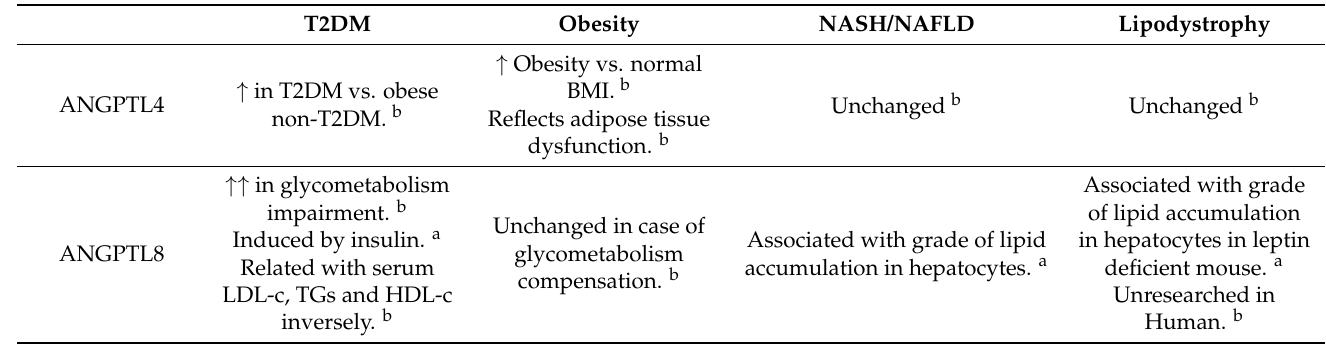
Table Legend: Levels of circulating ANGPTLs in common cardiometabolic diseases. a —studies in animal models. b —studies in human. Arrows indicate increase ( ↑ ) or decrease ( ↓ ) of ANGPTLs serum concentration. T2DM (type 2 diabetes mellitus); NAFLD (Non-Alcoholic fatty liver Disease); NASH (Non-Alcoholic Steatohepatitis); BMI (body mass index); TGs (triglycerides); HDL-c (high density lipoprotein cholesterol); LDL-c (low density lipoprotein